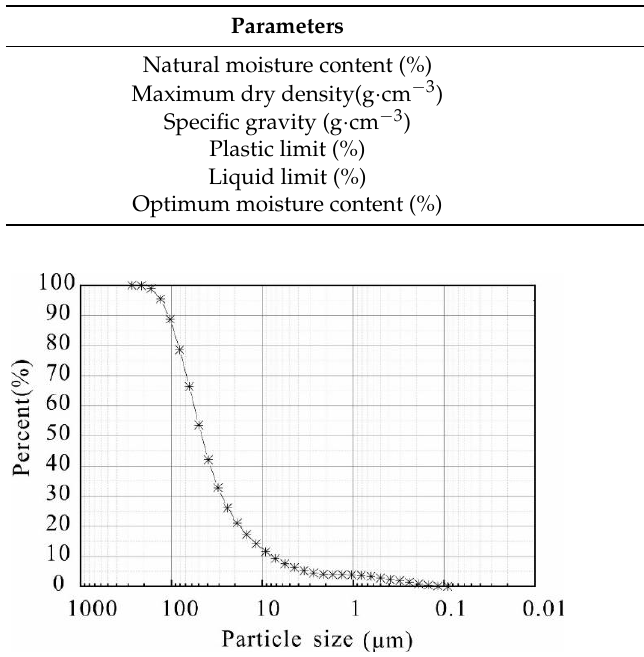
Figure 1. The grain size grading curve of the loess. Table 2. Properties of the reinforcement